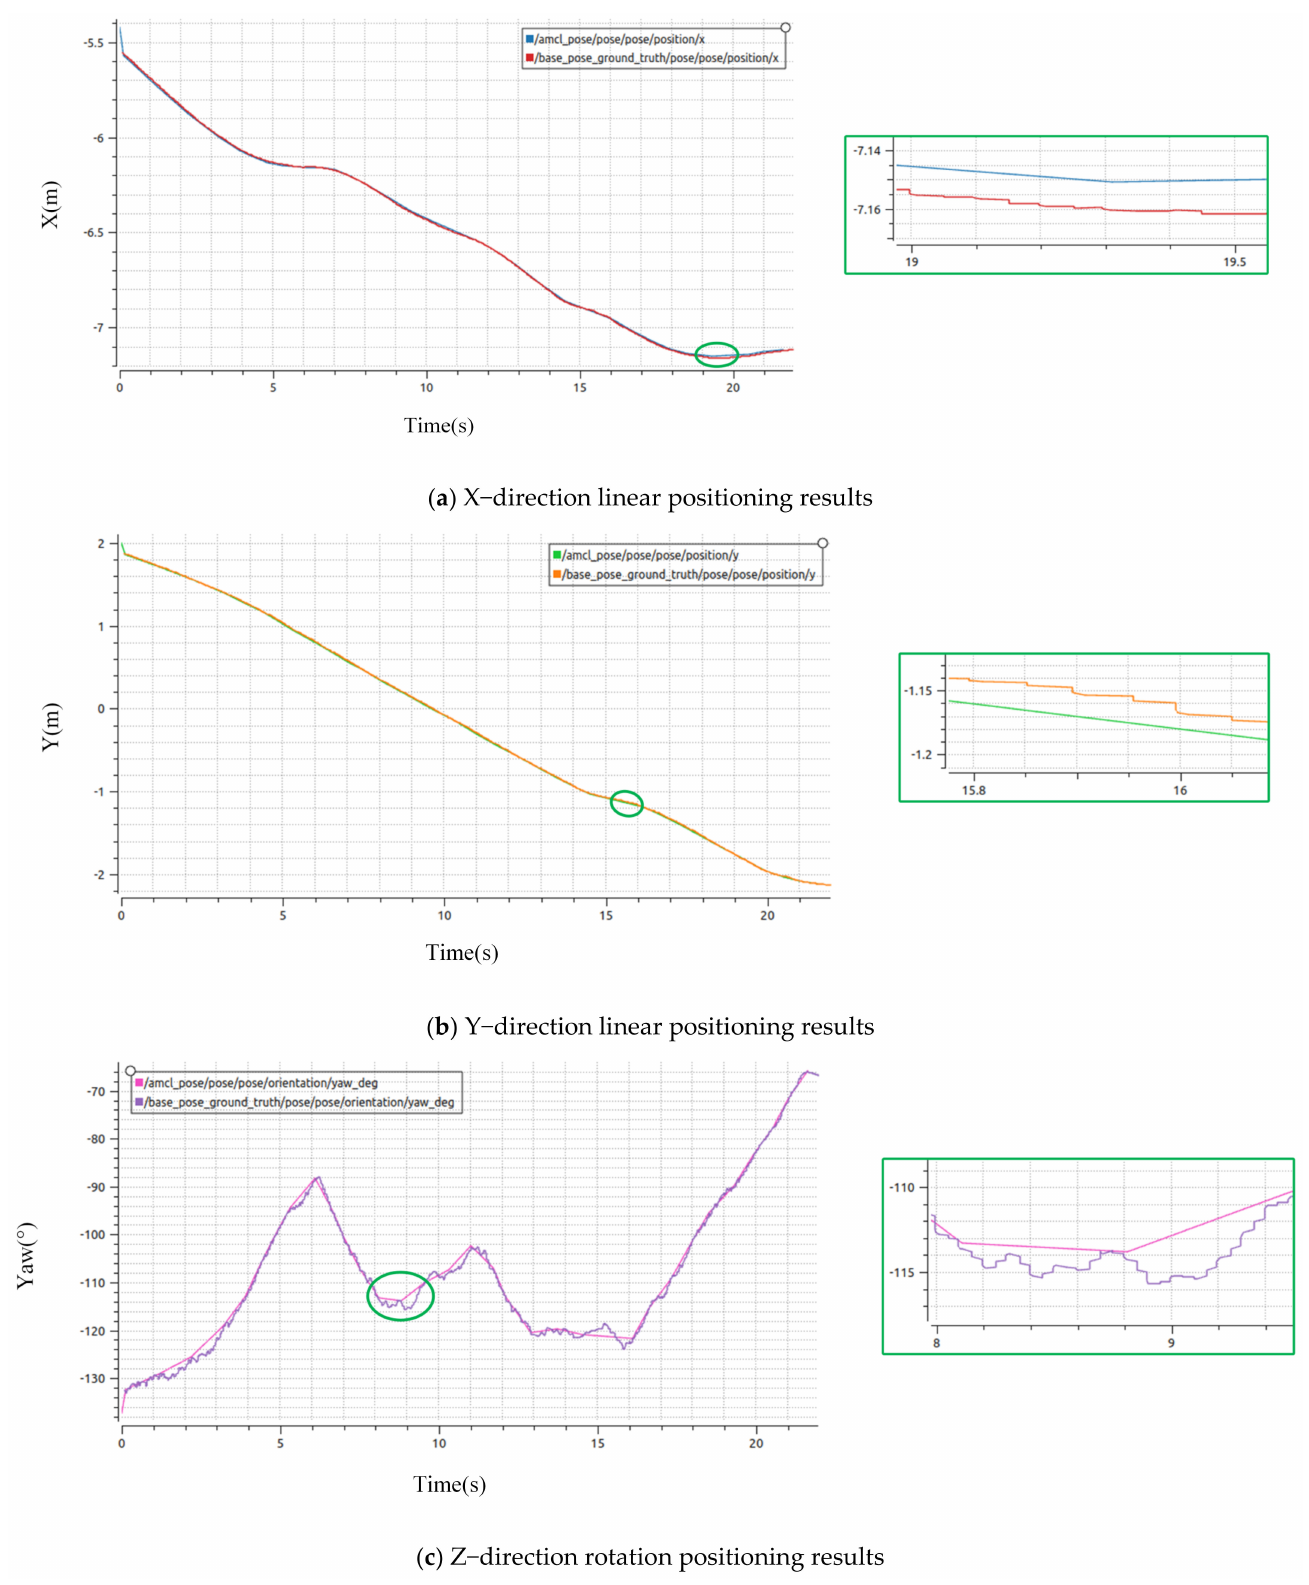
Figure 11. Results of the third group of improved AMCL simulation positioning